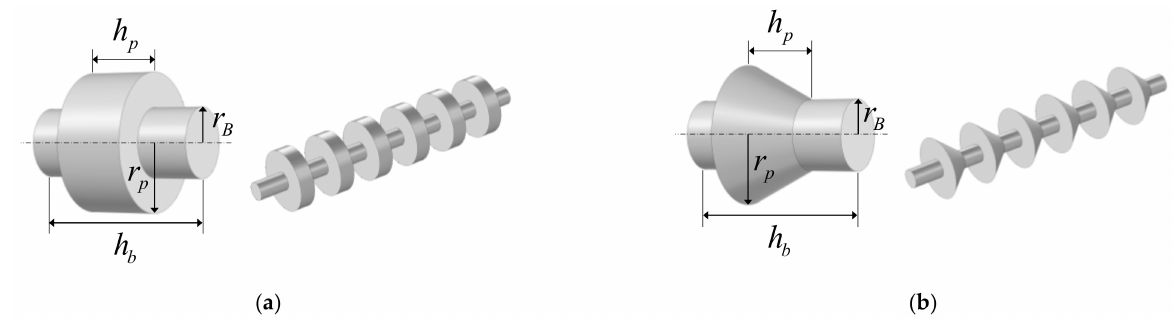
Figure 1. A representation of the periodic structure cell ( a ) Cylindrical metamaterials and ( b ) cone shape metamaterials.